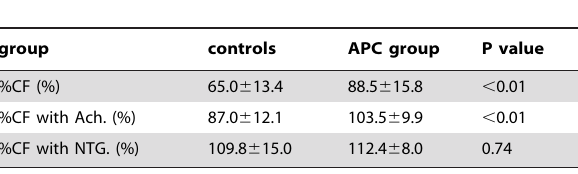
Table 2. Assessment of endothelial function in the global injury model.